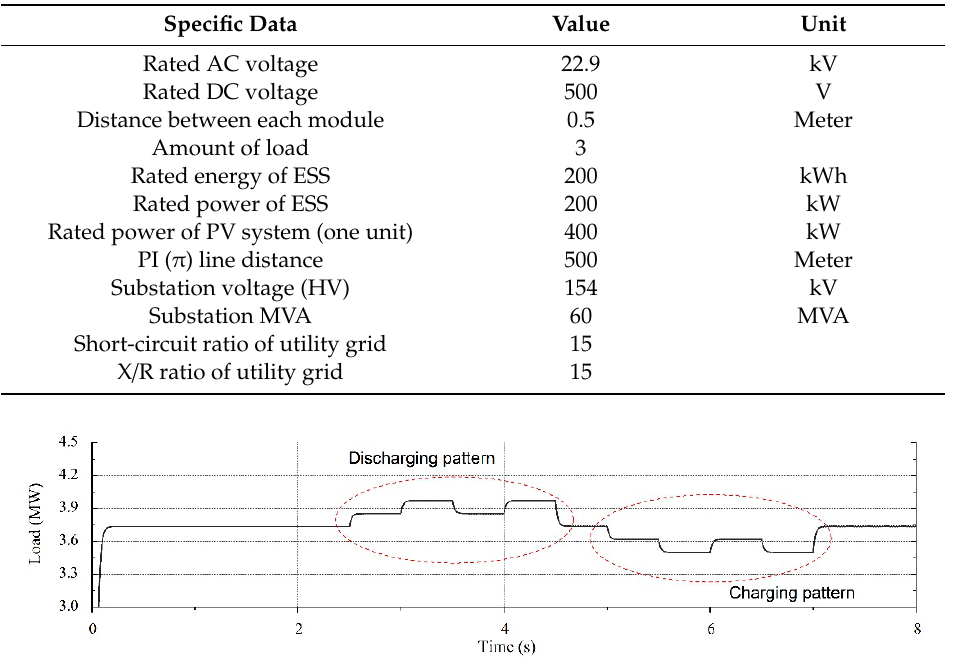
Figure 6. Imposed load variating condition for case study.